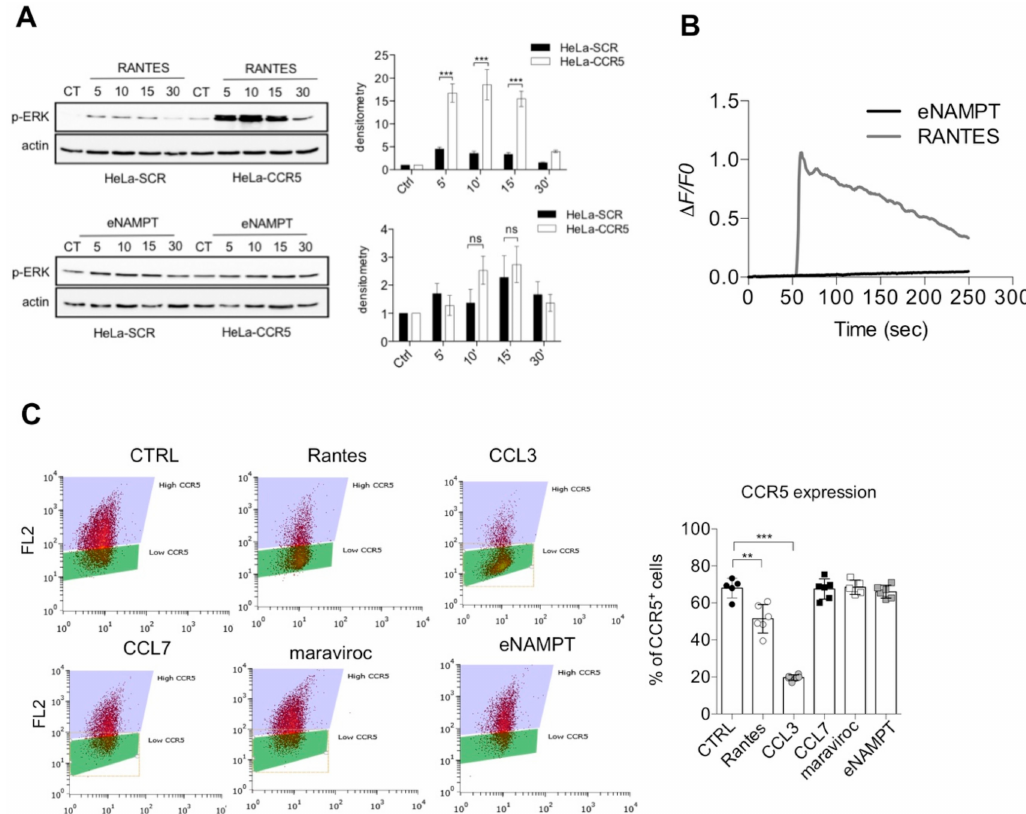
Figure 2. eNAMPT is not an agonist of CCR5. ( A ) Representative Western blot and densitometry analysis of phosphorylated ERK after 2 h of starvation followed by treatment for 5–30 min with recombinant Rantes (25 ng / mL; 3 nM) or eNAMPT (500 ng / mL; 9 nM) in serum-free conditions. Data from four separate experiments. ( B ) Representative calcium traces of HeLa-CCR5 loaded with FURA-2AM and stimulated with Rantes (25 ng / mL) or eNAMPT (500 ng / mL). Representative traces of 98–110 cells from 5–7 independent experiments. ( C ) Flow cytometry analysis of surface expression of CCR5 in HeLa-CCR5 cells treated for 1 h with Rantes (100 ng / mL = 12 nM), CCL3 (100 ng / mL = 9.9 nM), CCL7 (250 ng / mL = 22 nM), maraviroc (10 µ M), and eNAMPT (2.5 µ g / mL = 45 nM). The graph shows the mean ± S.E.M. of 12 determinations from four separate experiments. ** p < 0.01 *** p < 0.001; ns